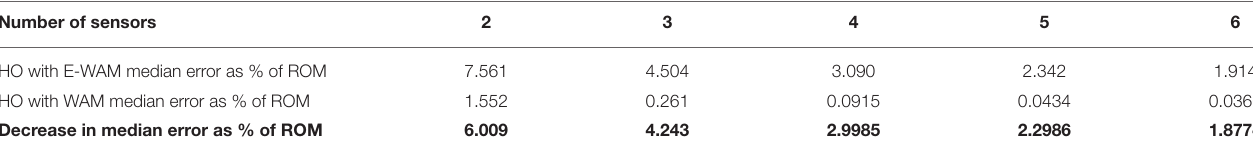
TABLE 3 | Table highlighting the difference in median error as a % of ROM between HO with E-WAM and HO with WAM. Number of sensors HO with E-WAM median error as % of ROM Decrease in median error as % of ROM